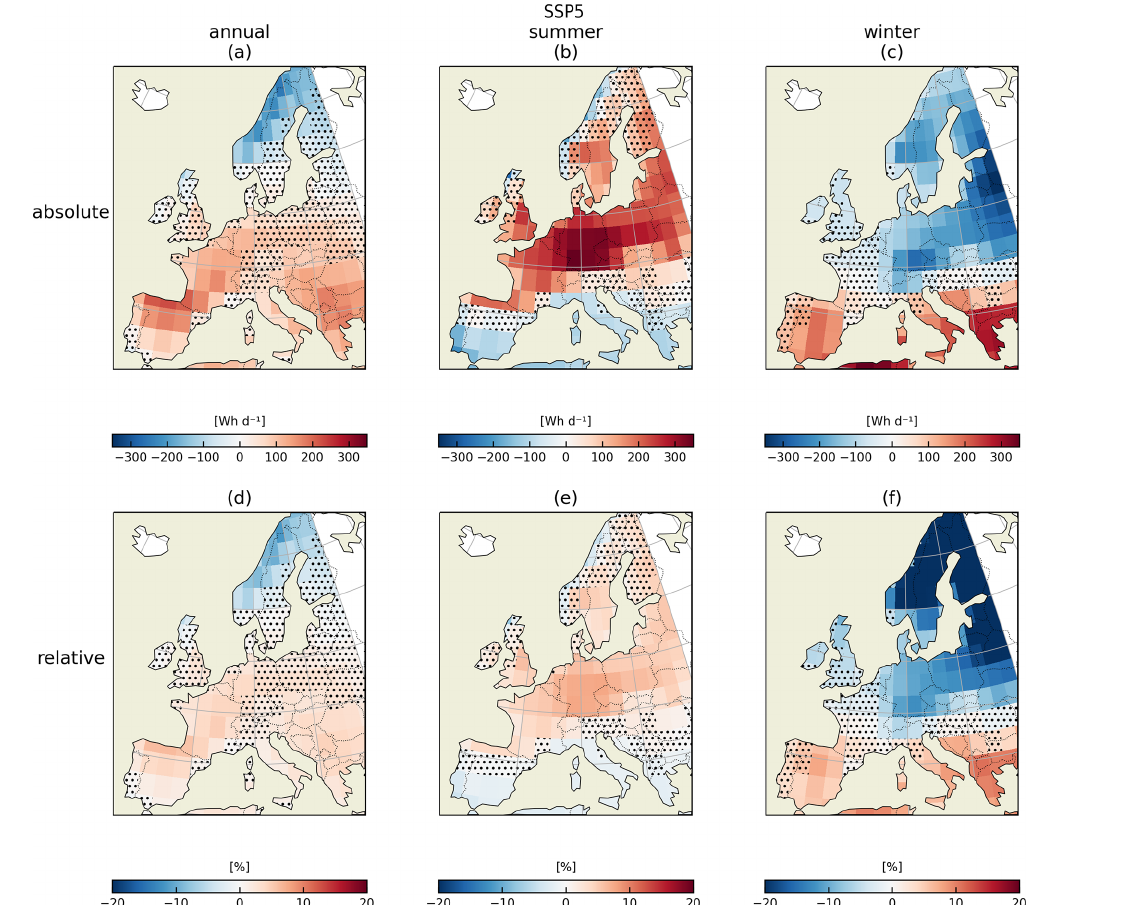
Figure 4. Impacts of climate change on PV generation in SSP5-8.5. The figure is structured in the same way as Fig.